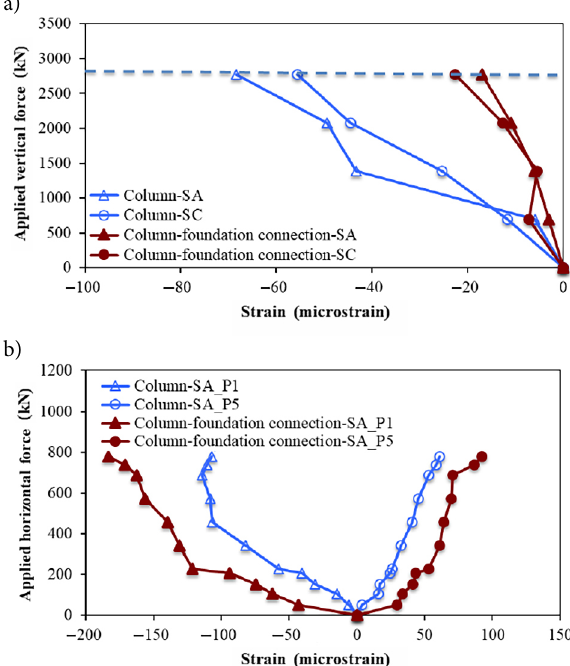
Figure 10. Normal strain in column and column-foundation connection for Type B in Stage 2: a – During the processes of vertical force applied; b – During the processes of